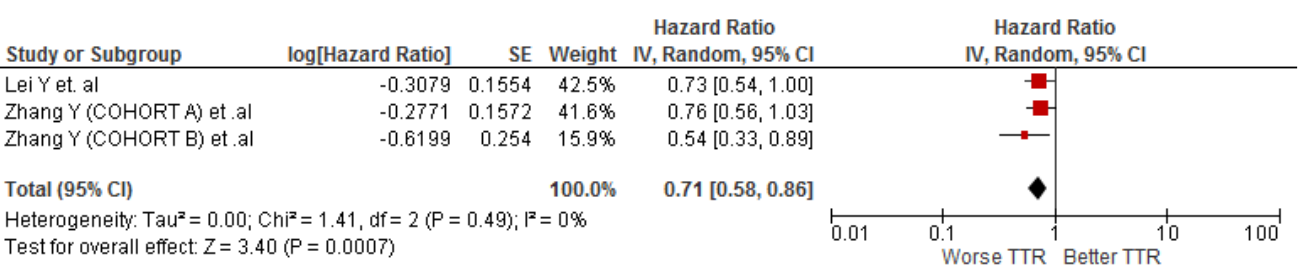
Figure 4. Association of LMR and RFS in patients with cholangiocarcinoma.